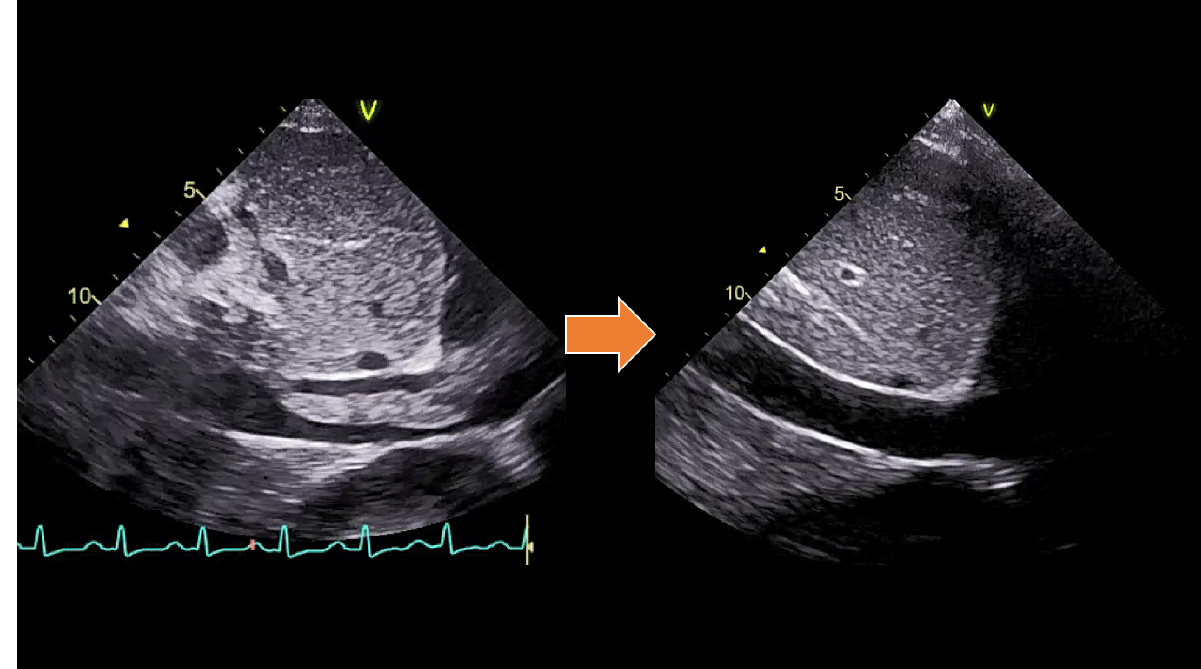
Figure 7. Transthoracic echocardiogram (TTE) comparison showing the position of the thrombus moving from the inferior vena cava towards the right